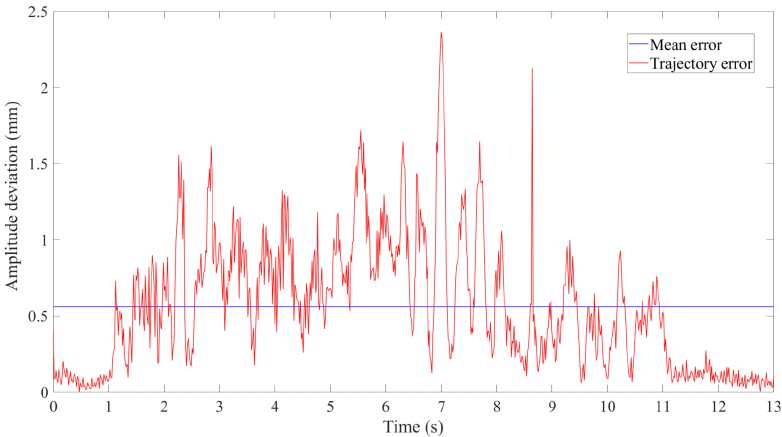
Figure 12. Deviation analysis of trajectory 1 and trajectory 2.